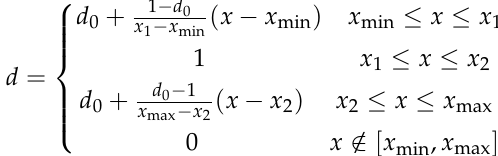
Figure 3. State space of qualitative indicator.